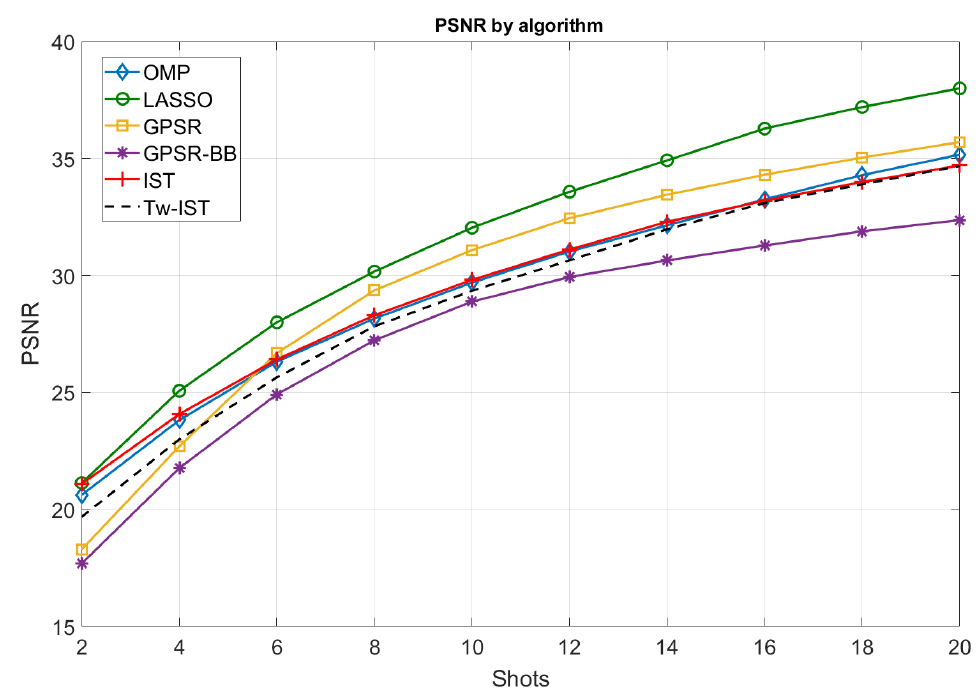
Figure 6. PSNR obtained for different sparse reconstruction